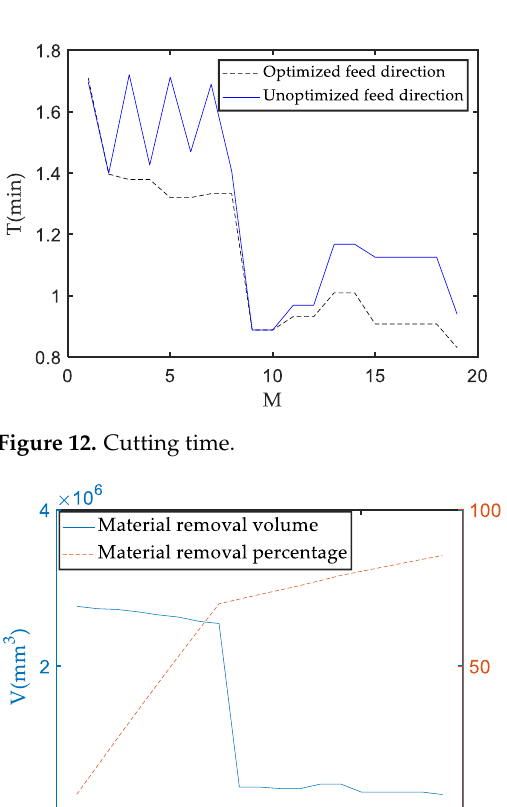
Figure 11. Dynamic reconstruction effect of CPH. ( a ) 1st cutting; ( b ) 8th cutting; ( c ) 19th cutting.